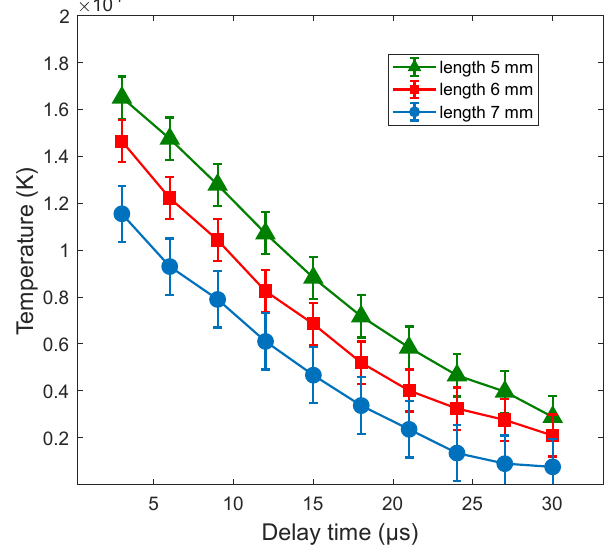
Figure 16. Time-resolved electron temperatures of the Ti plasma at different sizes of the circular cavity at a fluence of 23.3 J cm − 2 .